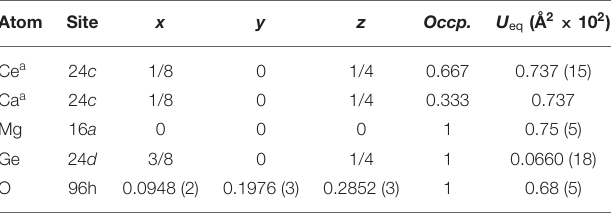
TABLE 2 | Atomic coordinates and equivalent isotropic displacement parameters U eq for Ce 2 CaMg 2 Ge 3 O 12 obtained from the structure refinement using single-crystal XRD data.